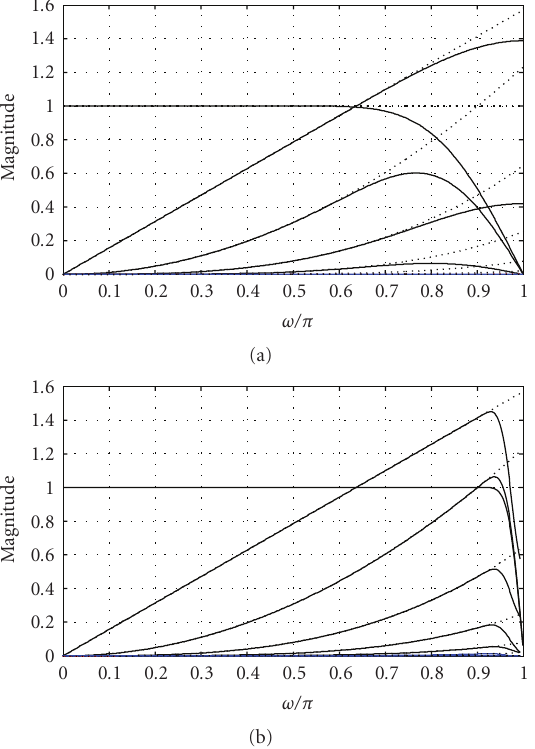
Figure 6: Di ff erentiators ideal responses (dot line) and approxima- tions (solid lines). (a) Proposed method ω p = 0 . 45 π , N = 12, and L = 14. (b) Direct all band optimization ω p = 0 . 9 π , N = 104, and L =